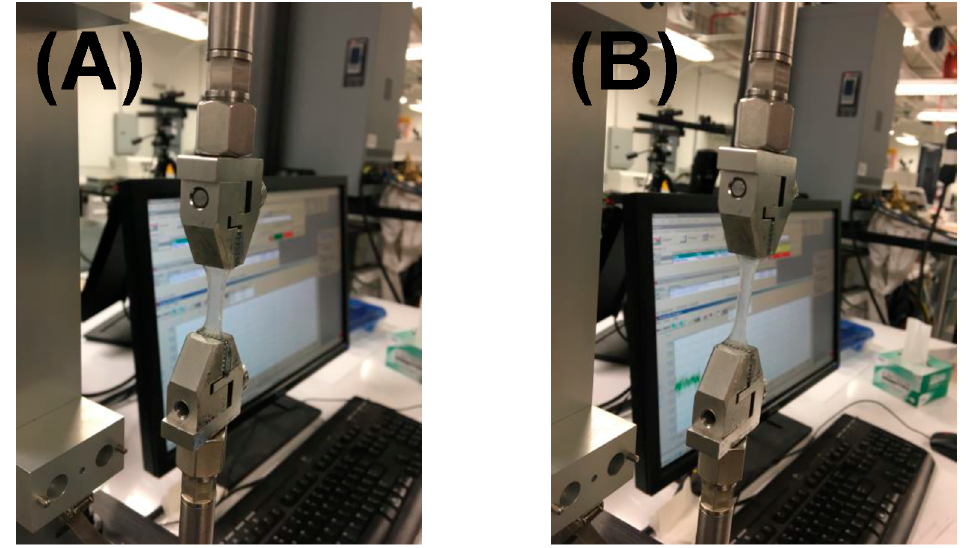
Figure 3. Mechanical testing to measure stiffness moduli of the hydrogels. Shown in ( A ) are the gels during the beginning of the experiment; in ( B ), the load is being applied and the gels appear stretched.